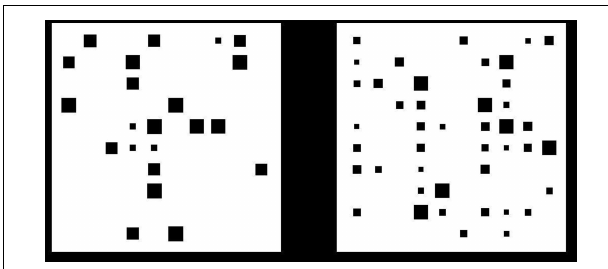
FIGURE 4 | Response latencies for compatible and incompatible comparisons separated for symbolic and structured non-symbolic notation and large vs. small unit distance. Error bars reflect 1